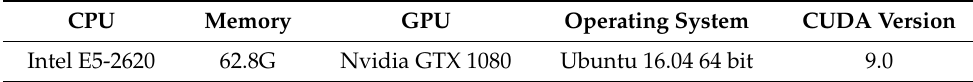
Table 1. Hardware and software information.